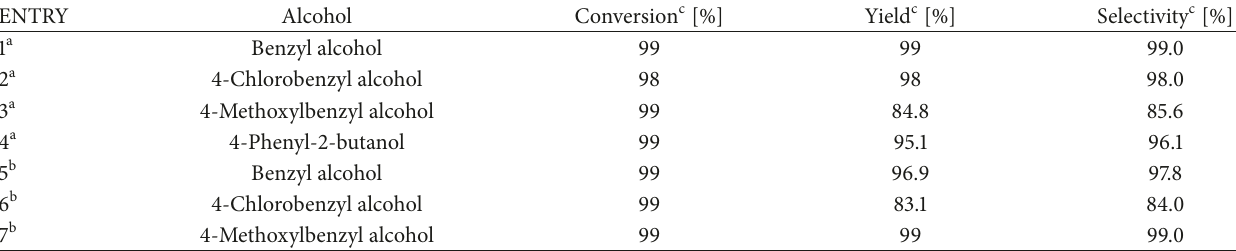
Table 2: TEMPO-MNPs mediated oxidation of alcohols to